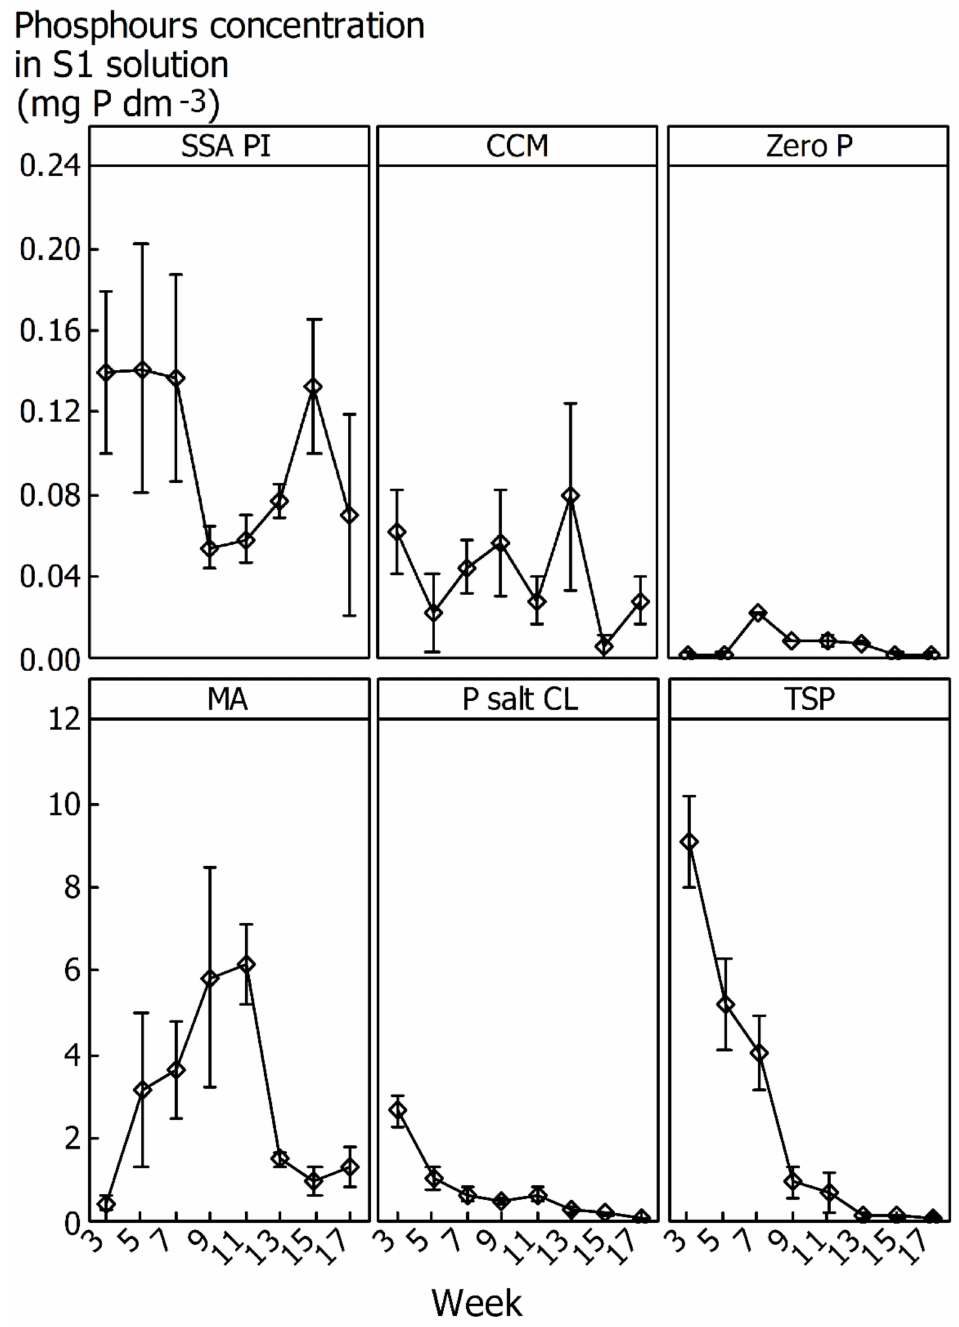
Figure 3. Phosphorus concentration in S1 pore water (mg P dm − 3 ) supplied with fertilizing products (TSP—triple superphosphate; P salt CL—chemically leached P salt; MA—microalgae; CCM—crab carapace material; SSA PI—sewage sludge ash obtained by pyrolysis and incineration; Zero P—no fertilizing product) over four months of plant growth. Shapes present mean values and error bars indicate standard deviation. Note: the upper three graphs have a lower Y -axis range than the bottom three